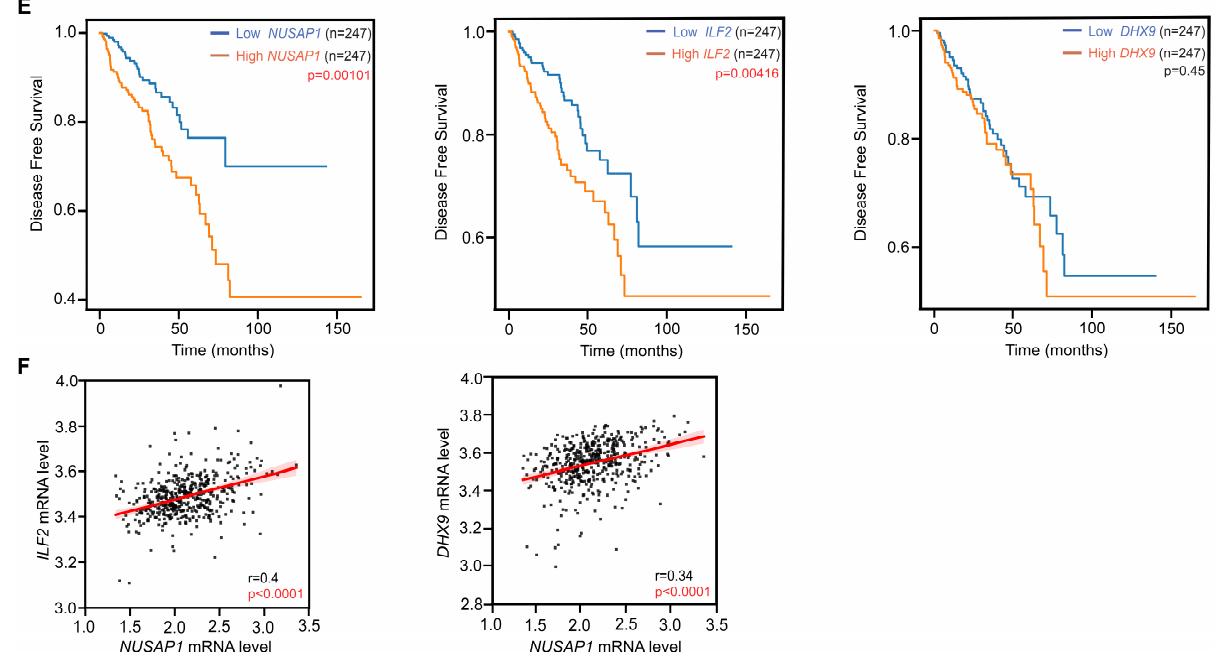
Figure 6. High NUSAP1 and ILF2 expression correlated with DNA repair pathways and adverse clinical features in prostate adenocarcinoma. ( A ) NUSAP1 mRNA levels were significantly higher in prostate adenocarcinoma compared to non-cancerous prostate tissues in the TCGA PRAD dataset. ( B ) GSEA demonstrated NUSAP1 mRNA level was positively correlated with the DNA repair path- way. ( C ) Heatmap of genes showing high correlation with NUSAP1 transcript levels. ( D ) NUSAP1 mRNA levels are associated with tumor grade (Gleason scores) while ILF2 and DHX9 mRNA levels were less correlated with tumor grade. ( E ) Kaplan–Meier analysis shows that increased NUSAP1 and ILF2 transcript levels, divided at the median, are associated with disease-specific survival; DHX9 expression levels are not associated with worse outcomes ( p -values by Log-rank test). ( F ) Pearson correlation coefficient analysis revealed that NUSAP1 mRNA level was significantly correlated with DHX9 and ILF2 mRNA levels. ****, p < 0.0001; NS, p >